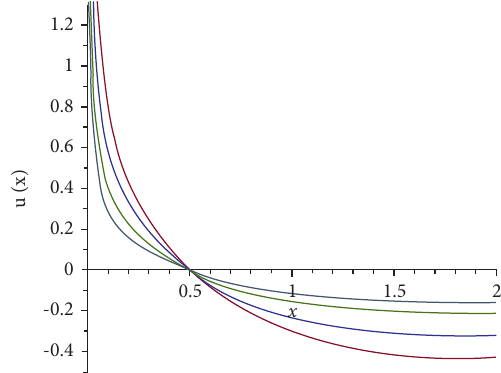
Figure 4: Plot of solution U